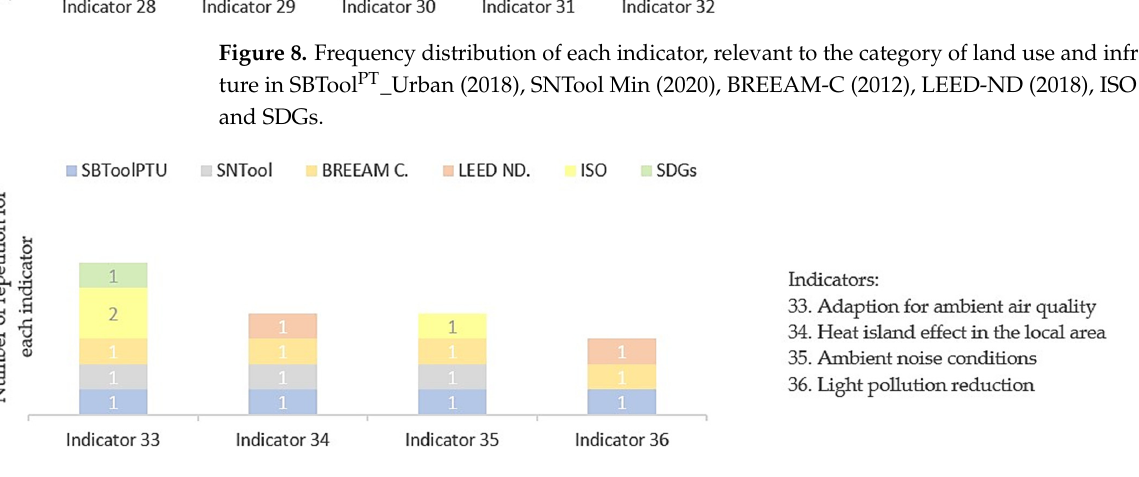
Figure 9. Frequency distribution of each indicator, relevant to the category of outdoor environmental quality in SBTool PT _Urban (2018), SNTool Min (2020), BREEAM-C (2012), LEED-ND (2018), ISO 37120 and SDGs.